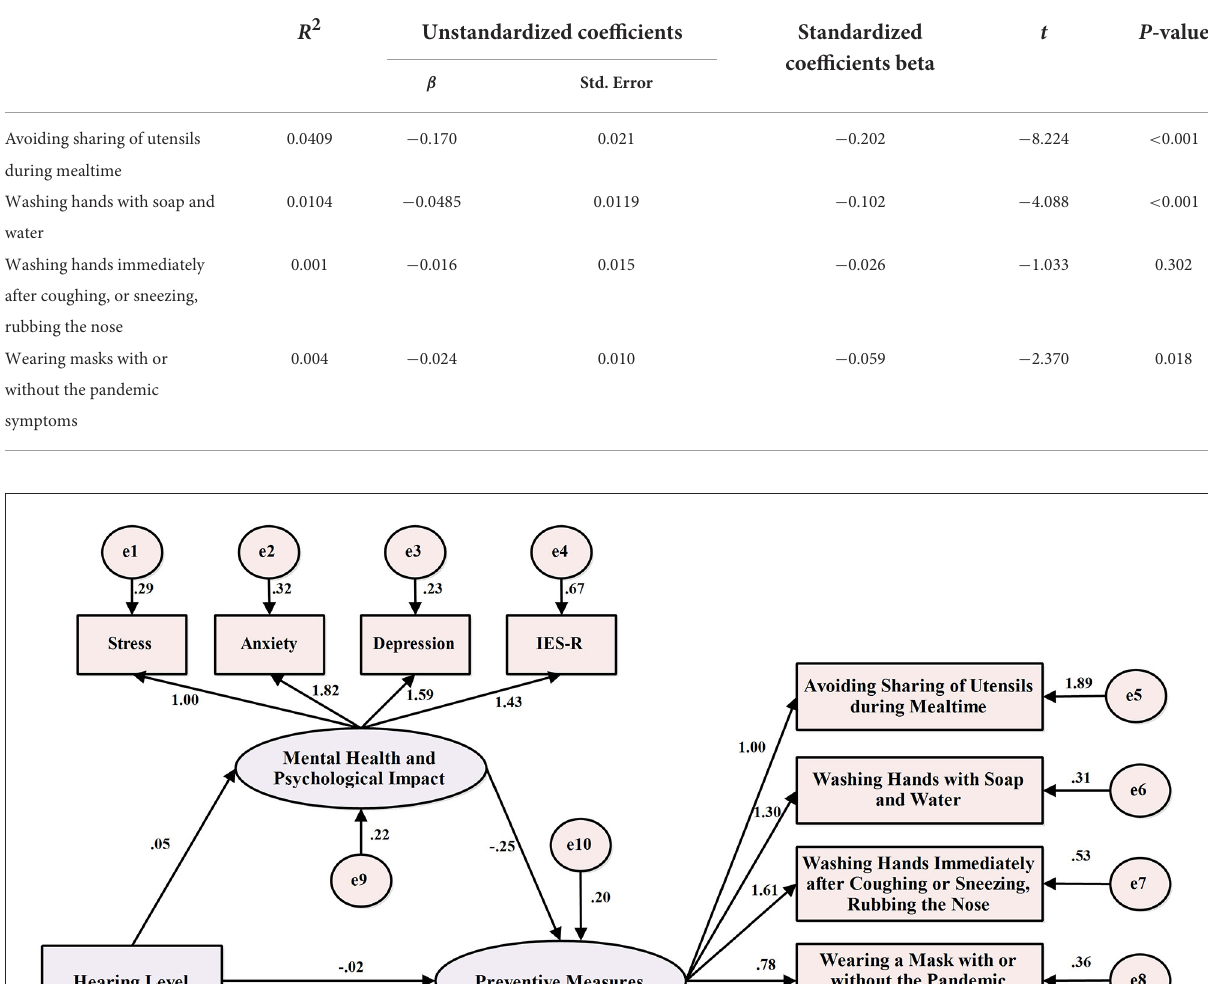
TABLE 4 The correlation between hearing level and the scores of four preventive health measures by the linear regression model.